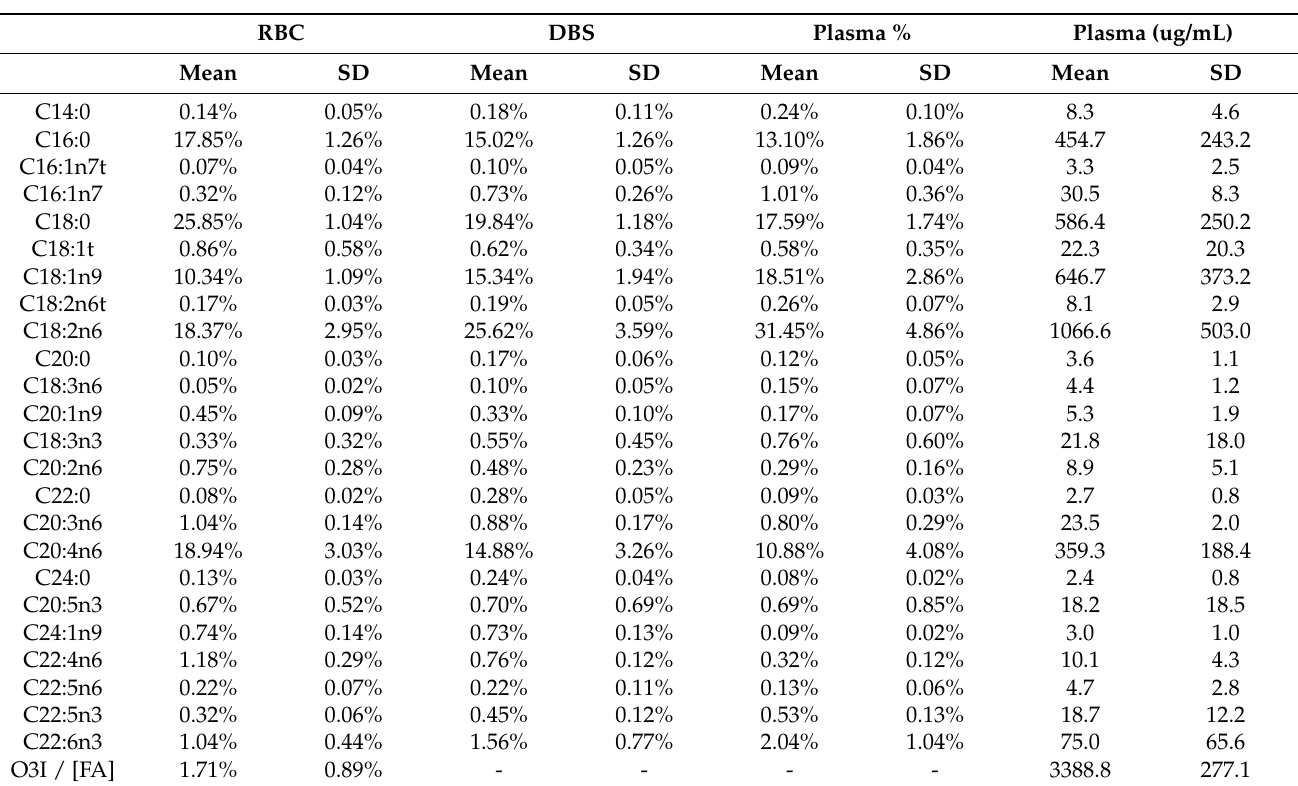
Table 3. Fatty acid composition of red blood cells, dried blood spots, and plasma (both as a percent of total fatty acids and as concentrations) from 10